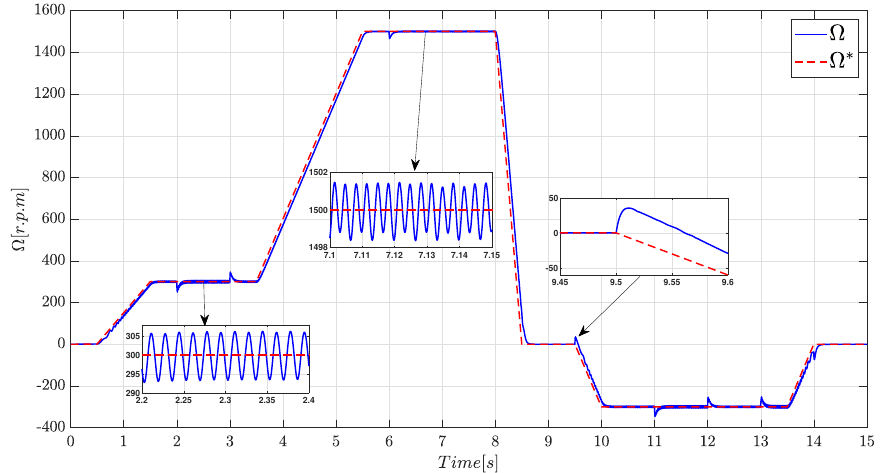
Figure 6. Velocity response obtained by PI controllers and conventional field-oriented control. During the different moments of the application of the load torque, small decreases in machine velocity are observed compared to the reference. In the same way, small overshoots appear when the load is canceled. These drops and overshoots disappear gradually to return to the reference, as shown by the zooms in the